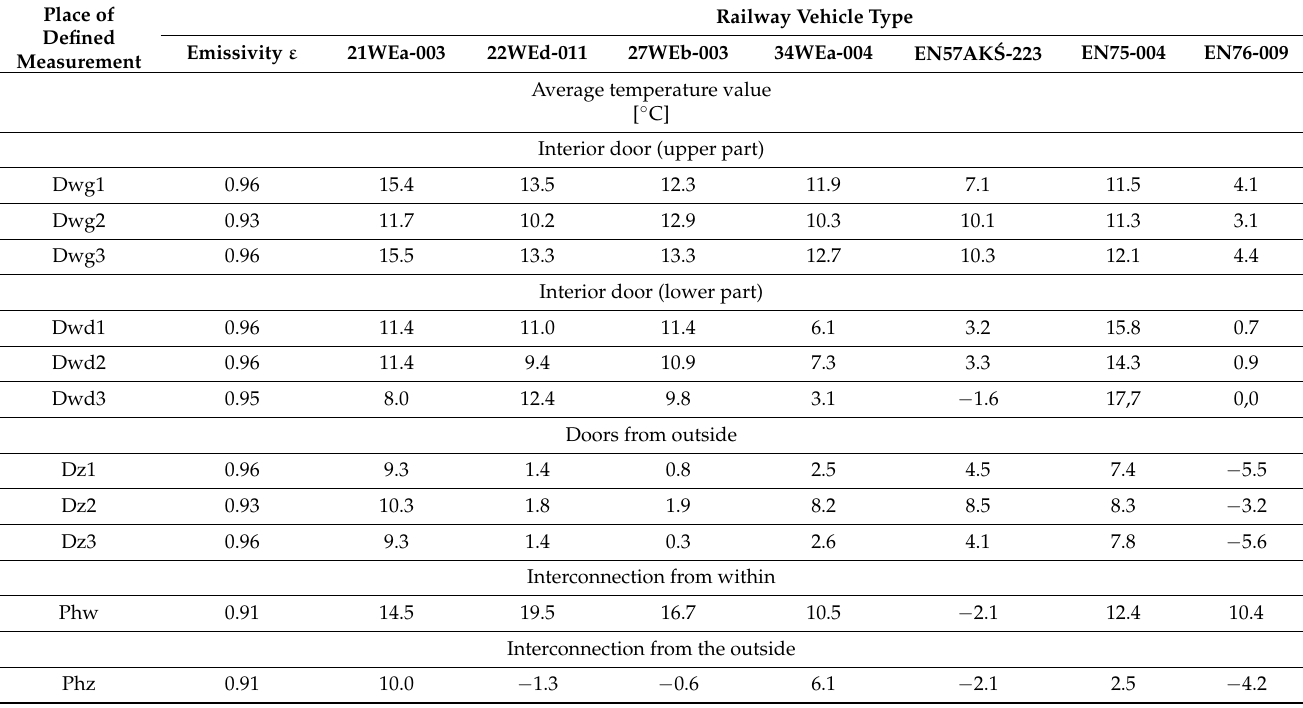
Table 4. Average component temperatures of the different types of railway